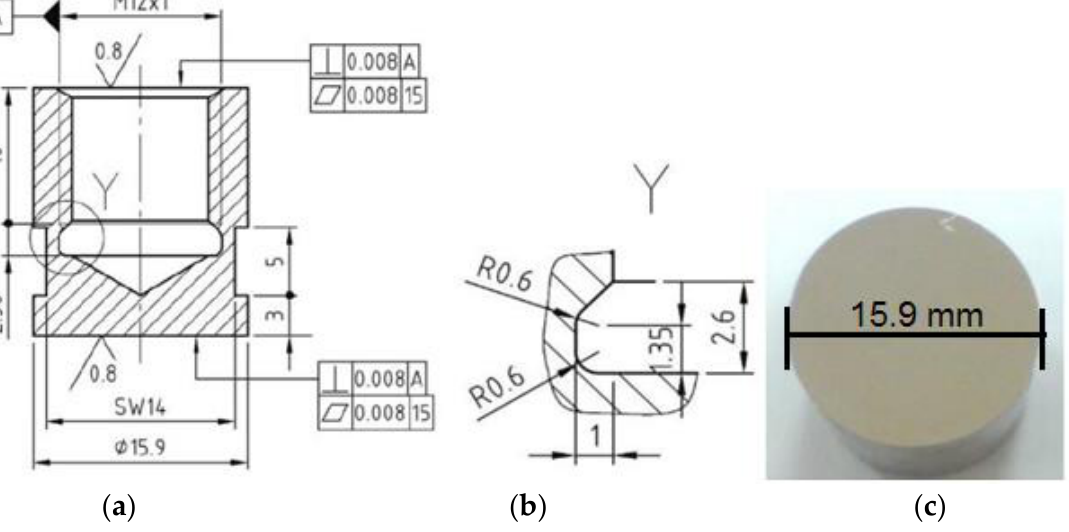
Figure 1. Cavitation sample: manufacturing details: ( a ) axial section through the sample, ( b ) detail of the Y area (thread clearance), ( c ) photo image of the sample surface, before the start of the cavita- tion attack (dimensions are in mm, according to general tolerance ISO 2768 1&2 standard).